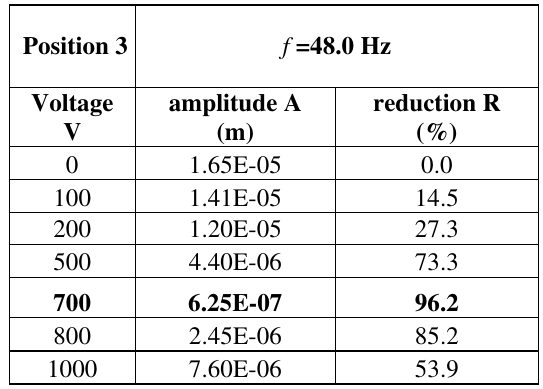
Table 1. Optimal voltage, reduction, and amplitude for the first